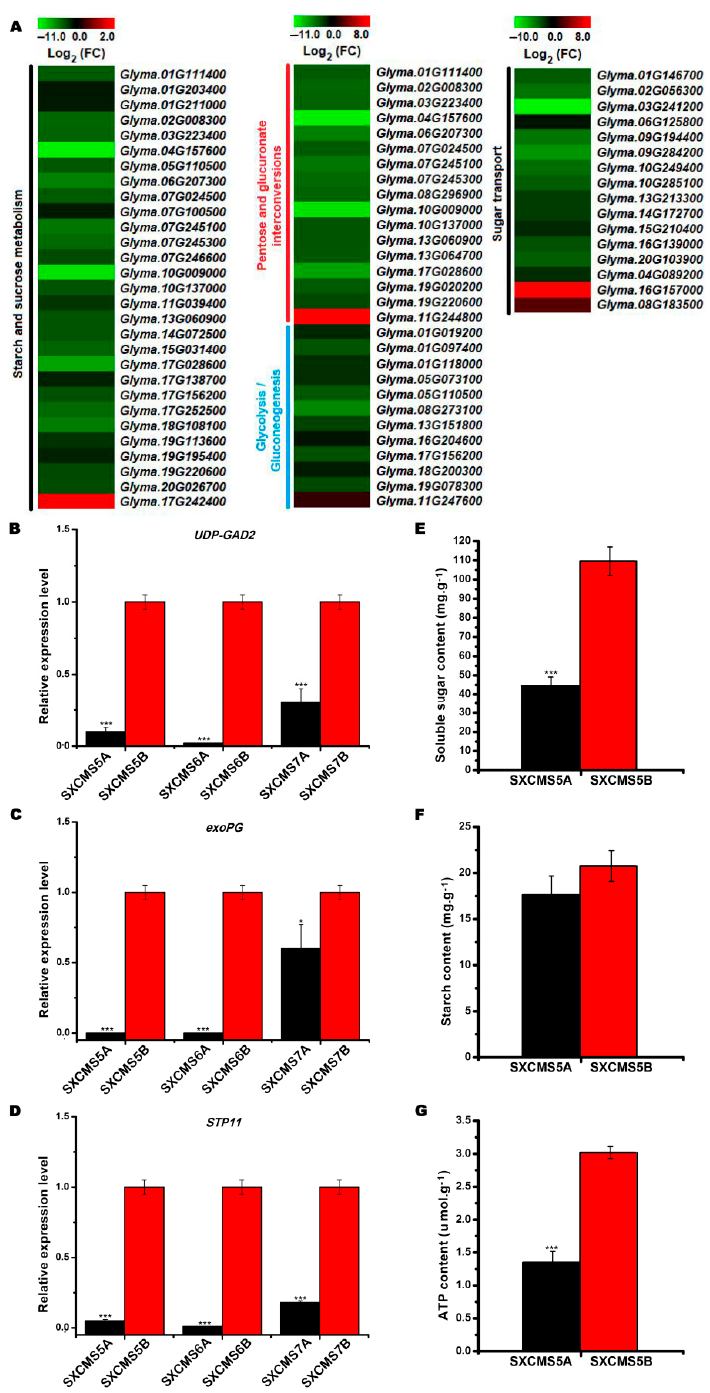
Figure 6. Analysis of DEGs related to carbohydrate metabolism and sugar transport between soybean CMS lines and their maintainers. ( A ) Heat map of the DEGs related to starch and sucrose metabolism, pentose and glucuronate interconversions, glycolysis/gluconeogenesis, and sugar transport between SXCMS5A and SXCMS5B. The heat map was created using MeV 4.9 software. Log 2 (FC) values were obtained from RNA-seq data. ( B – D ) Relative expression level of UDP-glucuronic acid decarboxylase 2-like ( UDP-GAD2 , Glyma.07G246600 ), exopolygalacturonase ( exoPG , Glyma.07G245100 ) and sugar transport protein 11 ( STP11 , Glyma.20G103900 ) between soybean CMS lines and their maintainers by qRT-PCR analysis. ( E – G ) Soluble sugar, starch, and adenosine triphosphate (ATP) contents analysis between SXCMS5A and SXCMS5B. Asterisk indicated statistical significance: *, p < 0.05; ***, p <